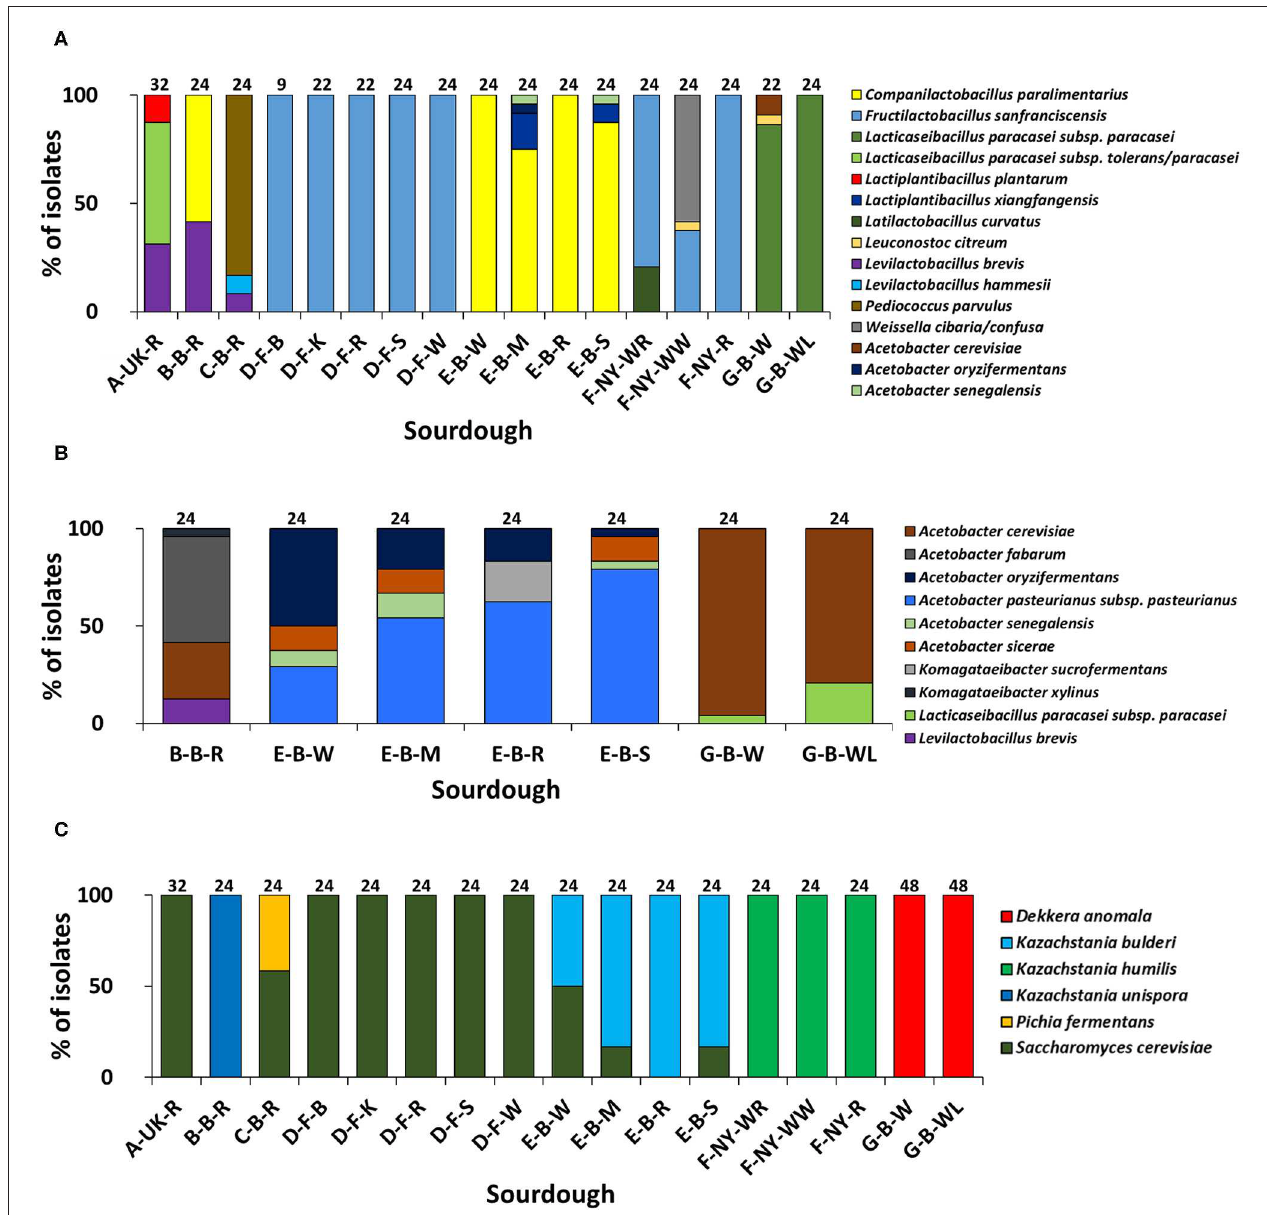
FIGURE 1 | Culture-dependent lactic acid bacterial (A) , acetic acid bacterial (B) , and yeast (C) species diversity of 17 sourdough samples from backslopped sourdoughs of different origins, based on 946 isolates randomly picked from mMRS-5, mDMS, and YPD agar media, respectively. The sample codes are as described in Table 1 . The following species were identified: Levilactobacillus brevis (99% identity; accession no. LC062897.1); Latilactobacillus curvatus (99% identity; accession no. LC063167.1); Levilactobacillus hammesii (99% identity; accession no. NR_042243.1); Lacticaseibacillus paracasei subsp. paracasei (100% identity; accession no. AP012541.1); Lacticaseibacillus paracasei subsp. tolerans/paracasei (99% identity; accession nos. LC065035.1/AP012541.1); Companilactobacillus paralimentarius (99% identity; accession no. LC096230.1); Lactiplantibacillus plantarum (100% identity; accession no. NR_113338.1); Fructilactobacillus sanfranciscensis (99% identity; accession no. NR_029261.2); Lactiplantibacillus xiangfangensis (99% identity; accession no. AB907194.1); Leuconostoc citreum (99% identity; accession no. LC096222.1); Pediococcus parvulus (99% identity; accession no. NR_113922.1); Weissella cibaria/confusa (99% identity; accession nos. LC096236.1/LC063164.1); Acetobacter fabarum (99% identity; accession no. HG329536.1); Acetobacter cerevisiae (98% identity; accession no. KF537424.1); Acetobacter pasteurianus subsp. pasteurianus (99% identity; accession no. KF537405.1); Acetobacter oryzifermentans (99% identity; accession no. CP011120); Acetobacter sicerae (98% identity; accession no. KF537395.1); Acetobacter senegalensis (99% identity; accession no. HG424424.1); Komagataeibacter xylinus (99% identity; accession no. FN391641.1); Komagataeibacter sucrofermentans (99% identity; accession no. FN391639.1); Dekkera anomala (99% identity; accession no.